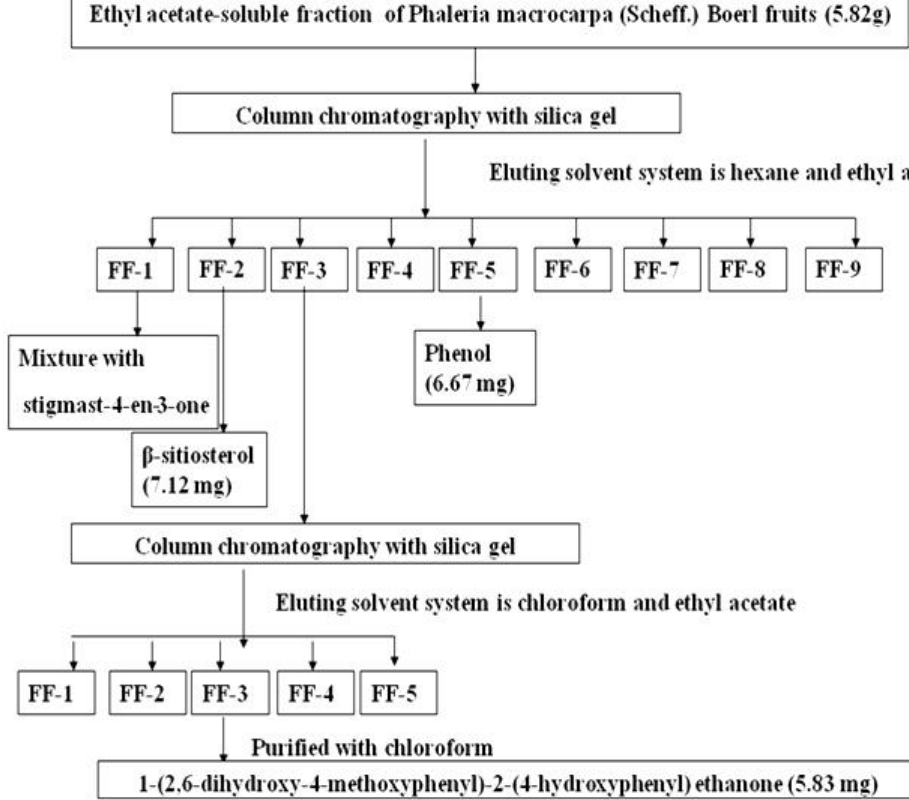
Figure 1. Flowing showing isolation of 1-(2,6-dihydroxy-4-methoxyphenyl)-2- (4-hydroxyphenyl) ethanone (DMHE) using silica gel column